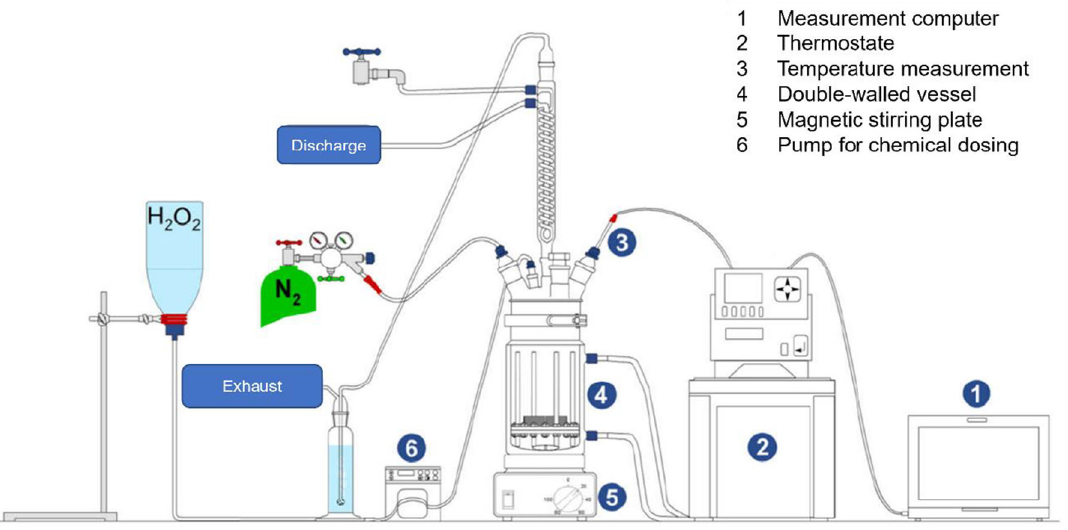
Figure 4. Schematical figure of t he experimental setup for leaching experiments with LFP cathode material